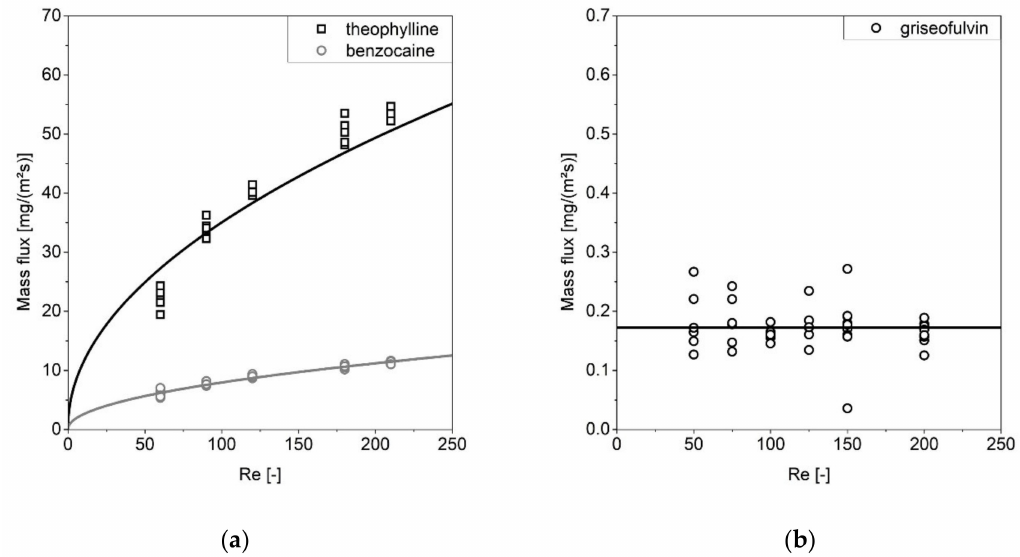
Figure 6. The resulting mass flux of benzocaine, theophylline ( a ) and griseofulvin ( b ) as a function of the Reynolds